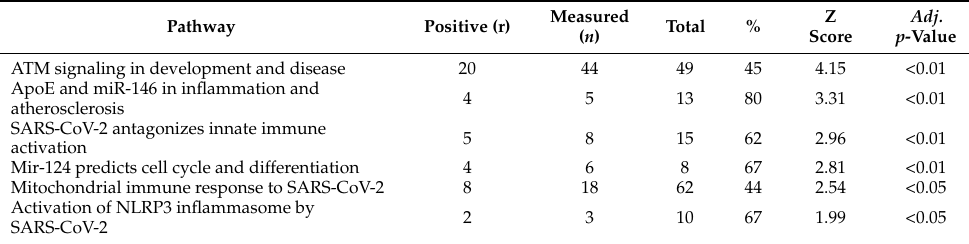
Table 3. Pathways overlapped in AFB1-exposure (100 nM) by PathVisio.